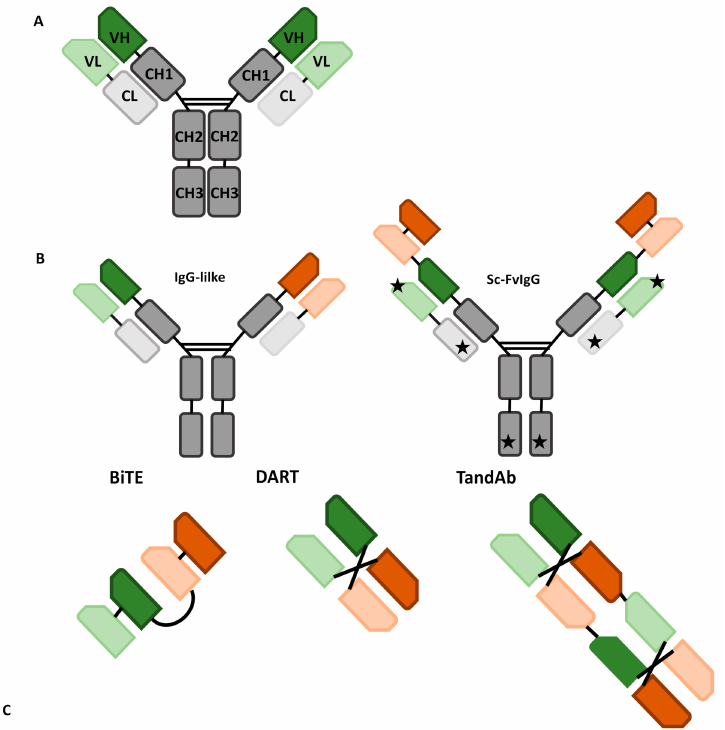
Figure 1. Examples of different antibodies: green and red are used for different specificities, while gray for the constant chains; and lighter colors indicate light chains, darker ones heavy chains. ( A ) Structure of a native antibody; CH: constant heavy chain, CL: constant light chain, VH: variable heavy chain, VL: variable light chain. ( B ) IgG-like antibodies; Sc-FvIgG: IgG-like antibody with added specificities through single chain fragment variables (stars indicate other sites which the ScFv can be bound to). ( C ) Non-IgG-like antibodies; BiTE: bispecific T-cell engager, DART: dual-affinity retargeting antibody, TandAb: tandem